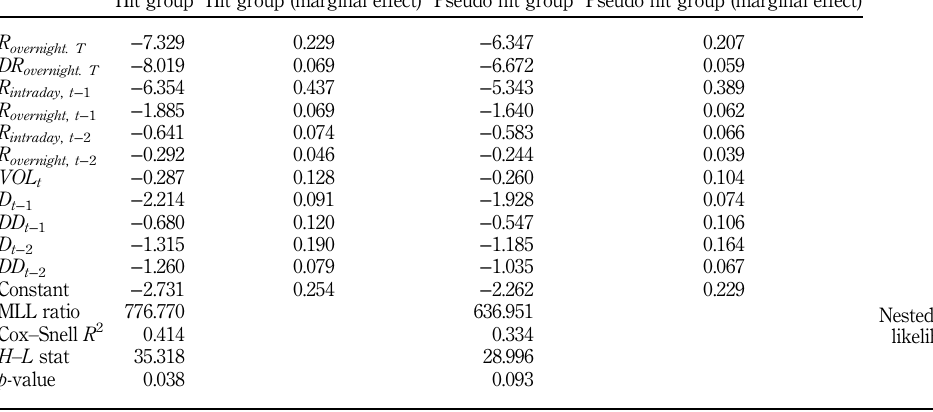
Table IX. Nested logit results on likelihood of ceiling hit in Regime